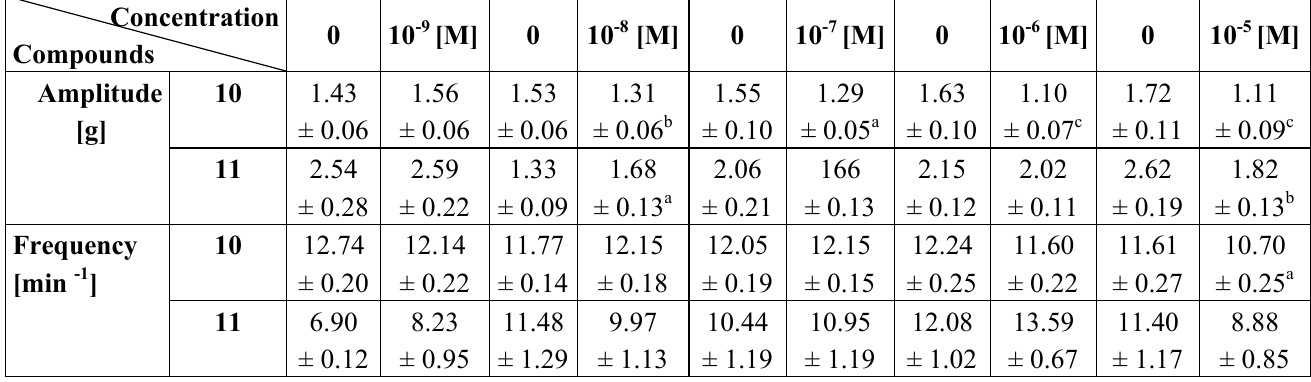
Table 4. The prophylactic antiarrhythmic activity in anesthetized